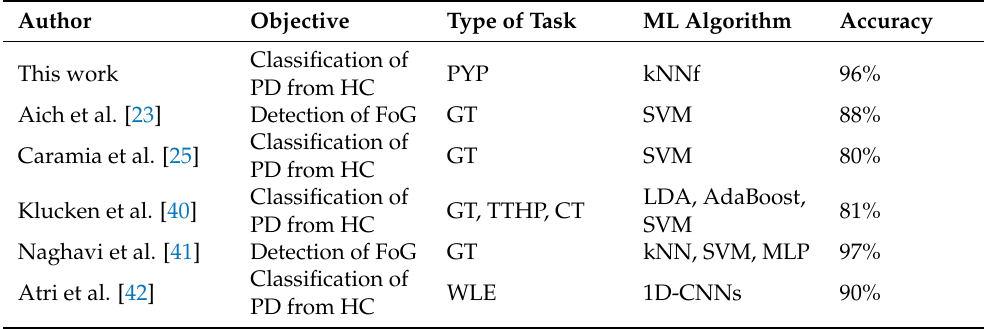
Table 5. A comparison of this work with state-of-the-art models’ work for activity detection. PYP (Postural Yaw Perturbation), GT (Gait Task), TTHP (Toe Tapping with Heel Pin), CT (Circling Test), WLE (Walk-like events), LDA (Linear Discriminant Analysis), MLP (Multilayer Perceptron), 1D-CNN (One-dimensional Convolution Neural